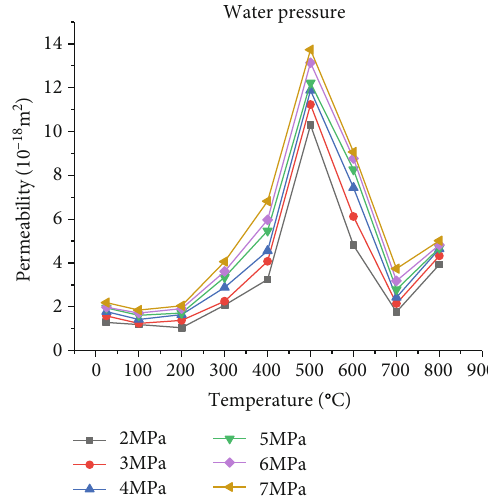
Figure 8: Permeability of the sandstones considering axial pressure 10 MPa and con fi ning pressure 16MPa considering di ff erent heated